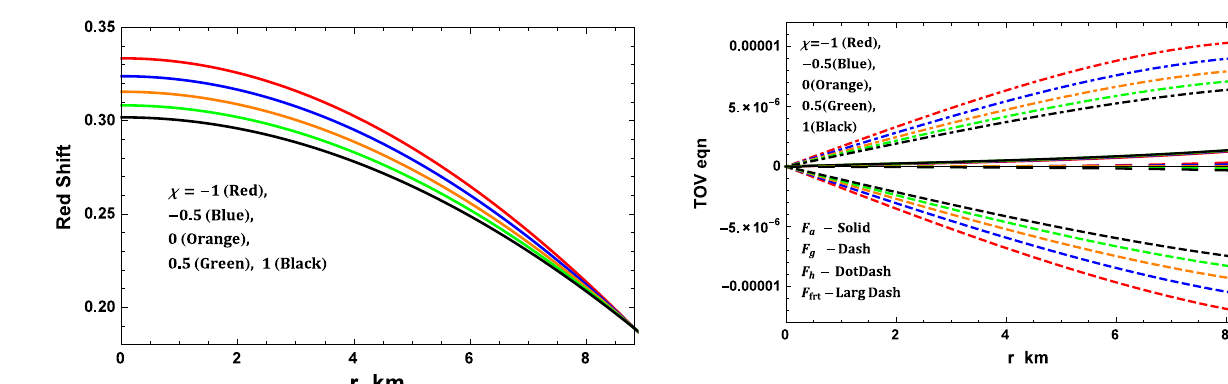
Fig. 8 TOV-equation profile of SMC X-4 for M = 1 . 29 M (cid:9) , R = 8 . 831 km and b = 0 . 0031km −